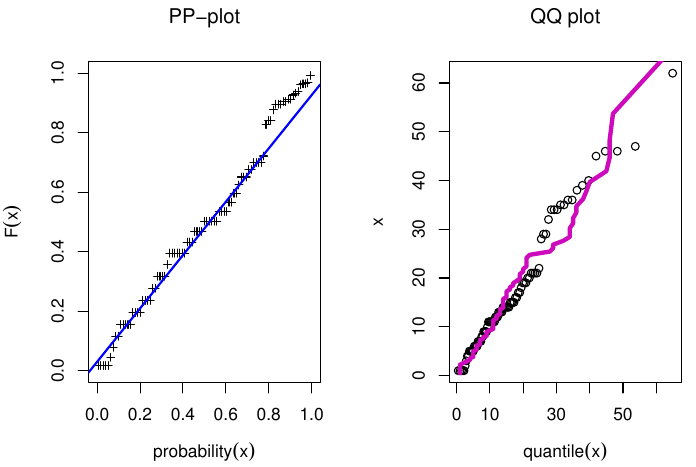
Figure 6. Cdf for different models for COVID-19 data.